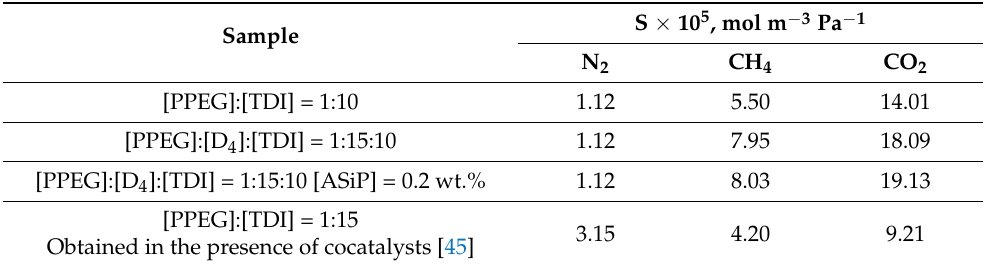
Table 5. Sorption